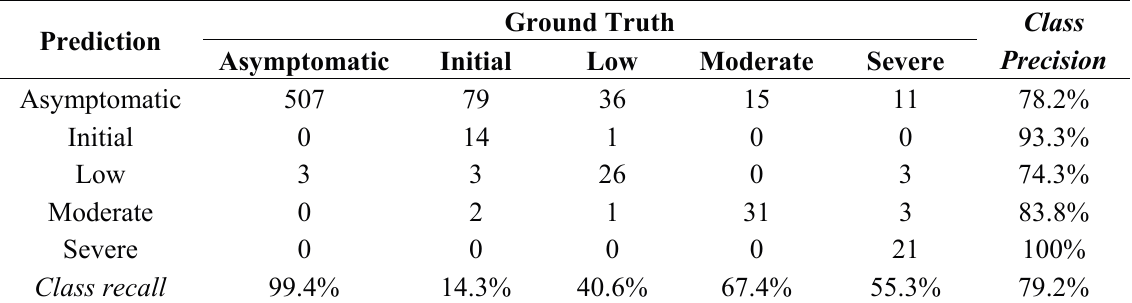
Table 8. Confusion matrix for Verticillium wilt severity classes using the support vector machine classification based on the indices selected by the forward stepwise discriminant